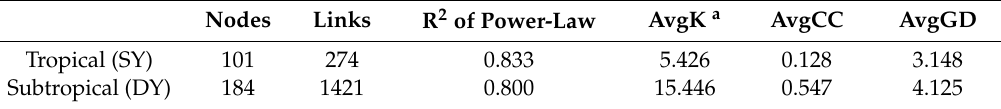
Table 2. Major properties of molecular ecological network.